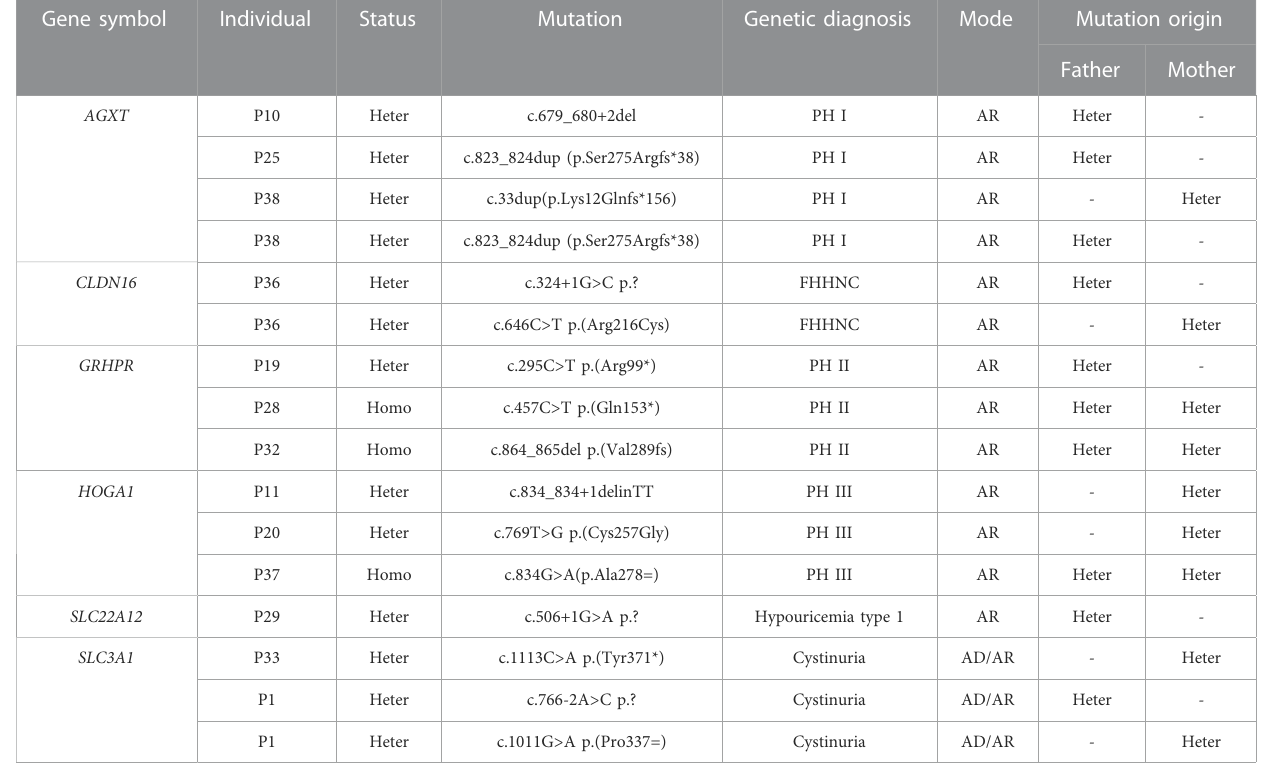
TABLE 2 Pathogenic mutations of six genes detected in 13 individuals.